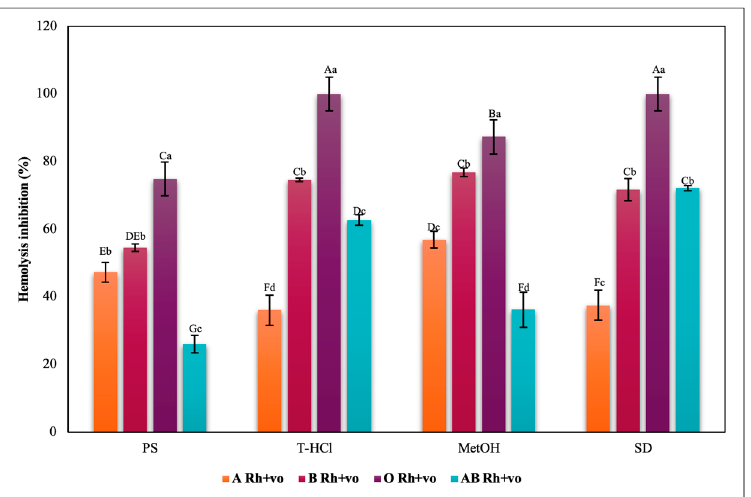
Figure 13. Inhibitory effect of hypotonicity-induced hemolysis of P. cruentum extracts on human erythrocytes with different ABO blood groups. Different letters represent significant differences in the means between treatments and groups ( p ≤ 0.001). Capital letters represent a two-way ANOVA. Lowercase letters represent a univariate ANOVA between the extracts. PS, extract of physiological solution; T-HCl, 0.5 M Tris-HCl extract; MetOH, 99% methanol extract; SD, sodium diclofenac.